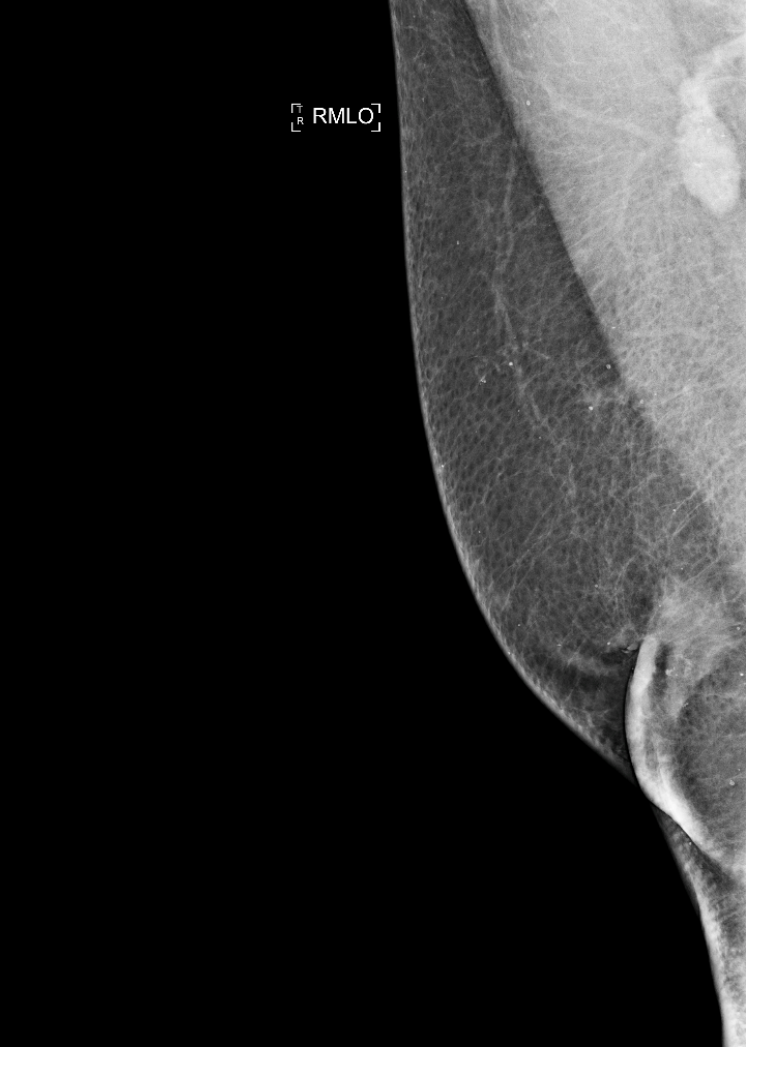
Figure 8. Man with retroareolar tumor and skin thickening. Endogenous causes of hyperoestrogenization in men, including obesity, cirrhosis,